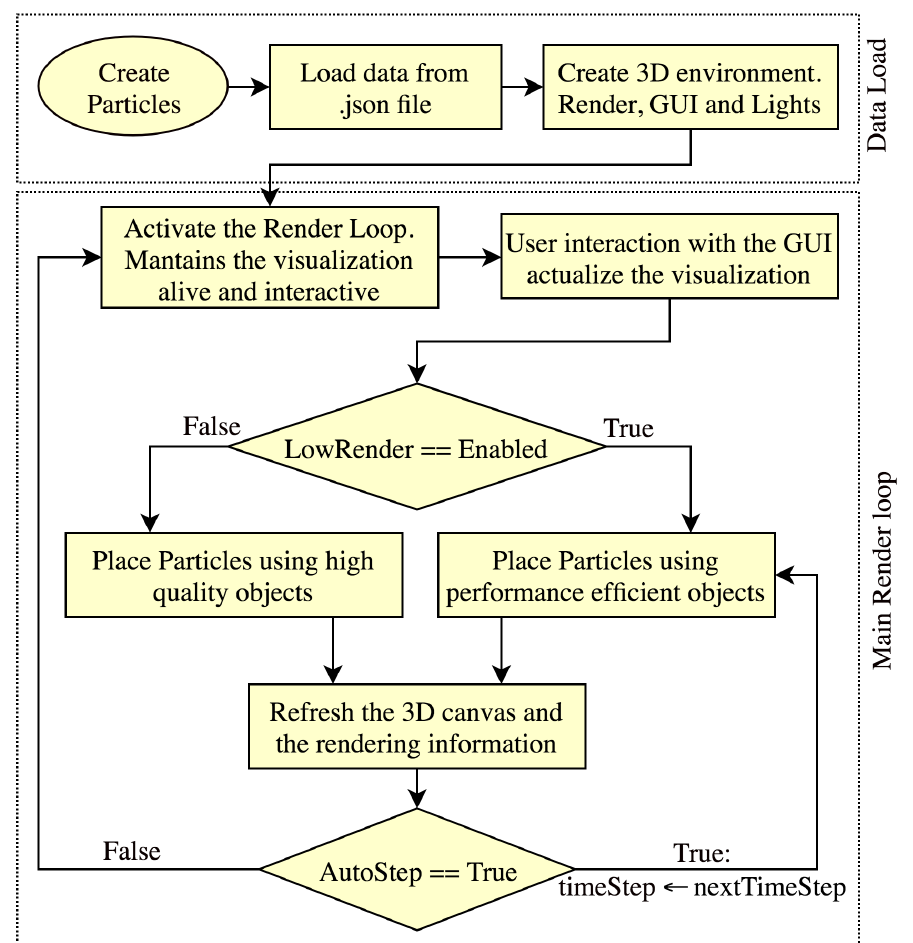
Figure 3. Diagram that shows the code workflow from the data load to the 3D model